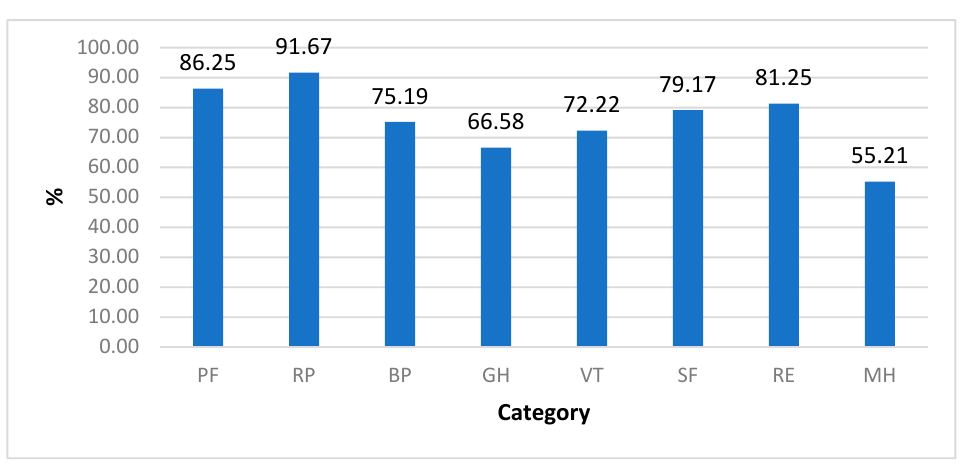
Figure 4. Mean results in 8 categories, SF-36 in %. PF—physical functioning; RP—physical role functioning; BP—bodily pain; GH—general health perceptions; RE—emotional role functioning; SF—social role functioning; MH—mental health; VT—vitality.